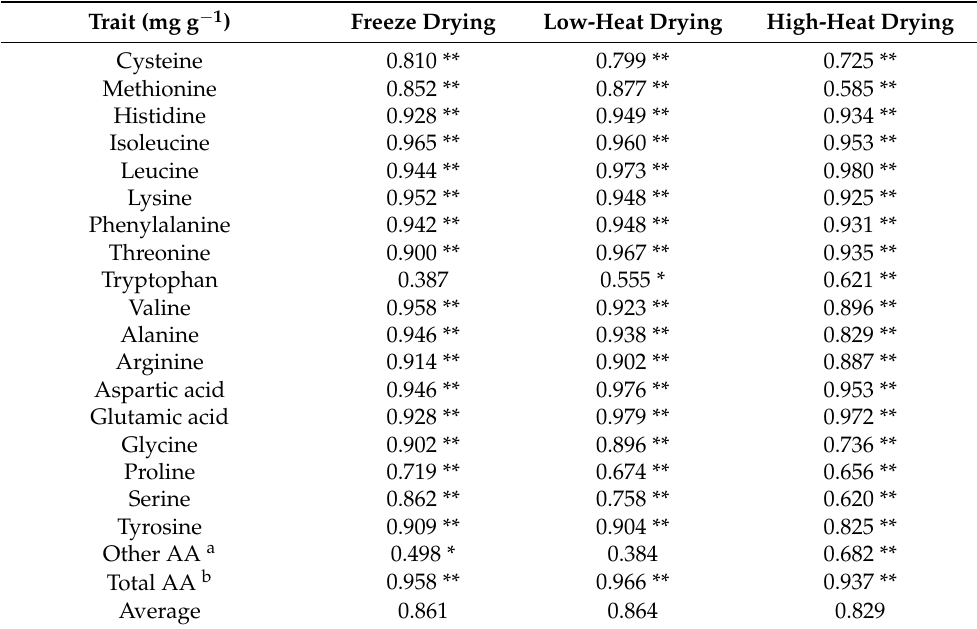
Table 4. Correlation coefficients between ground and whole seed samples in seed amino acid traits of edamame dried by different drying